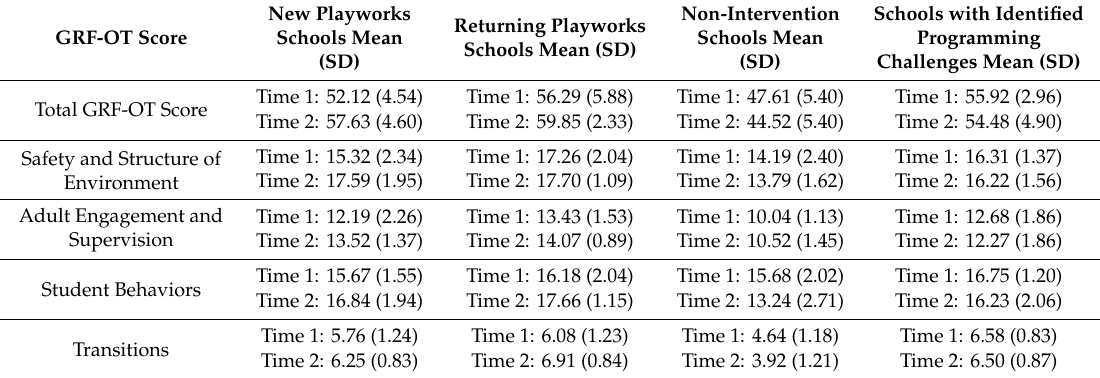
Table 2. Descriptive Data for Time 1 and Time 2 GRF-OT and GRF-OT